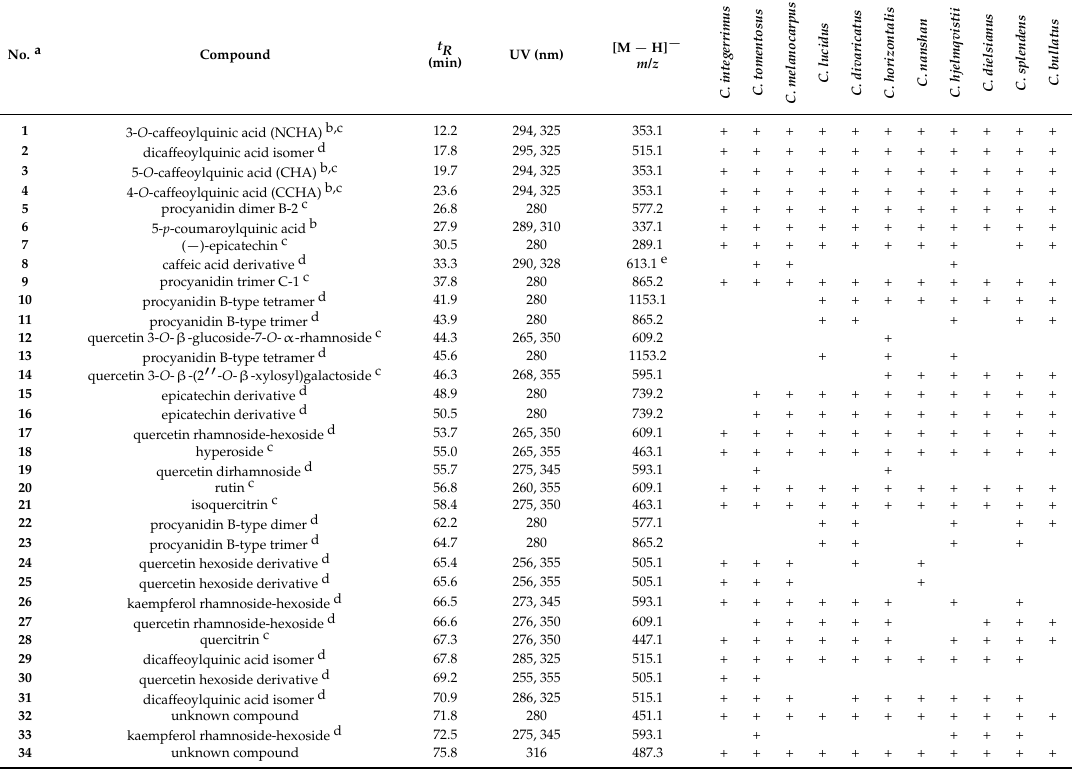
Table 1. UHPLC-PDA-ESI-QTOF-MS data of identified polyphenols in the Cotoneaster leaf extracts.